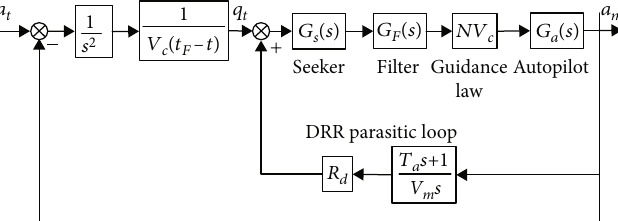
Figure 16: The guidance system model of the roll-pitch seeker.